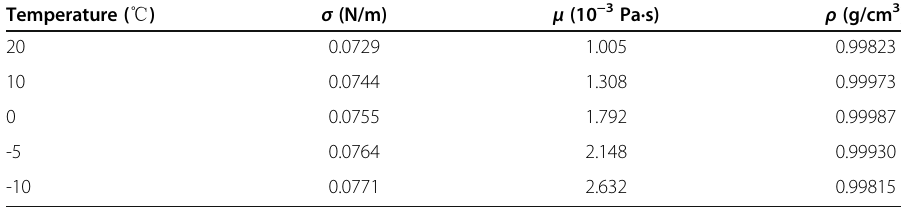
Table 2 Physical parameters of water at different